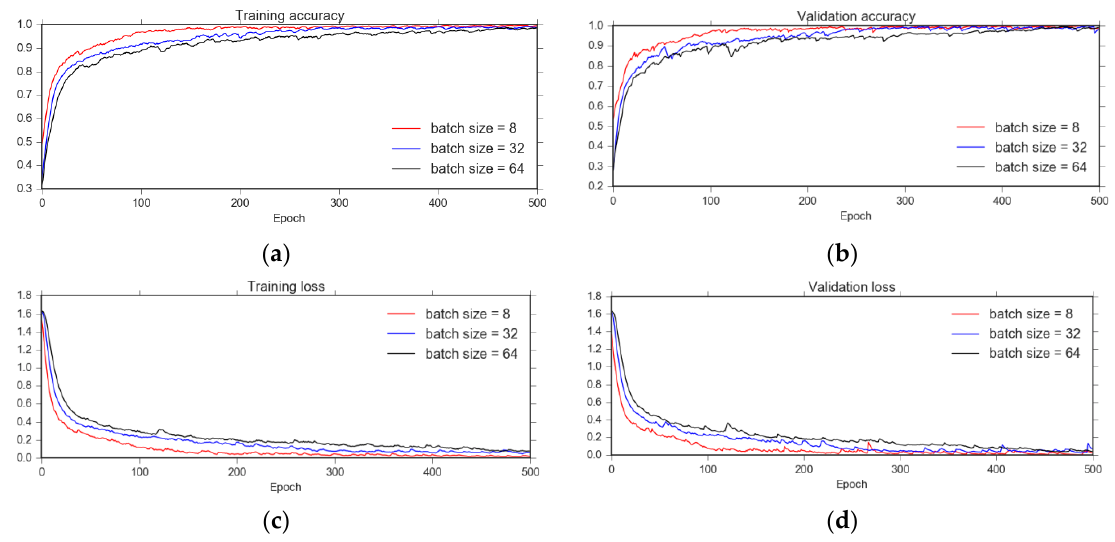
Figure 10. Effect of batch size: ( a ) Training accuracy plot; ( b ) Validation accuracy plot; ( c ) Training loss plot; ( d ) Validation loss plot.